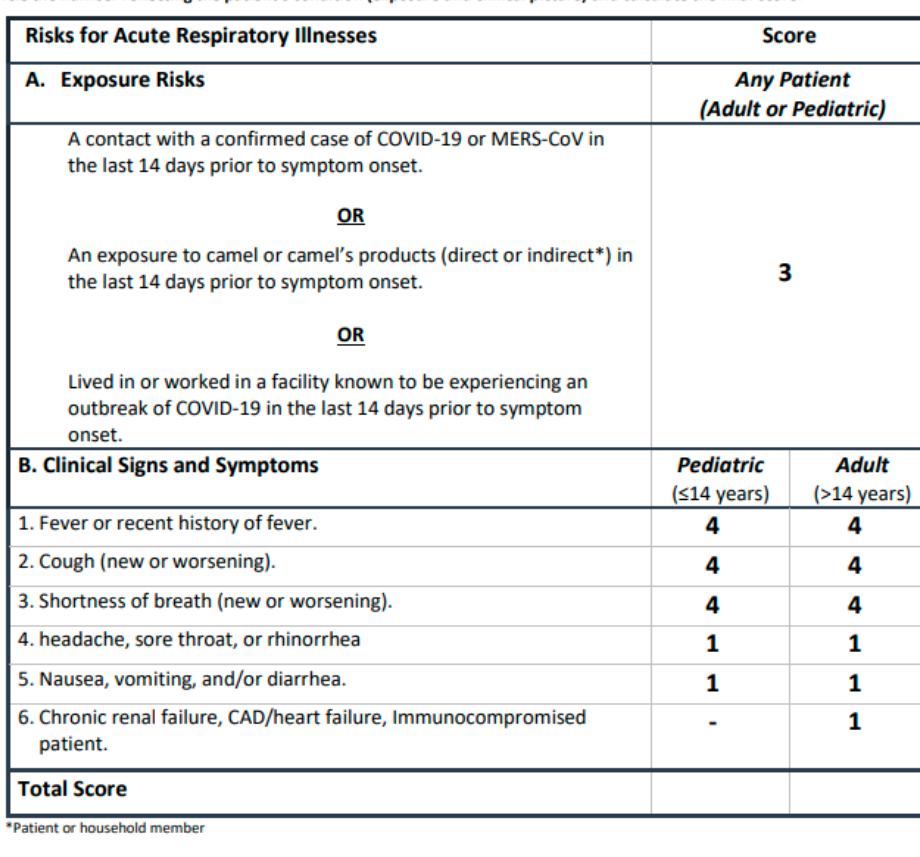
Figure 7. Virtual Triage Checklist at MOH, version v1.3 [64].